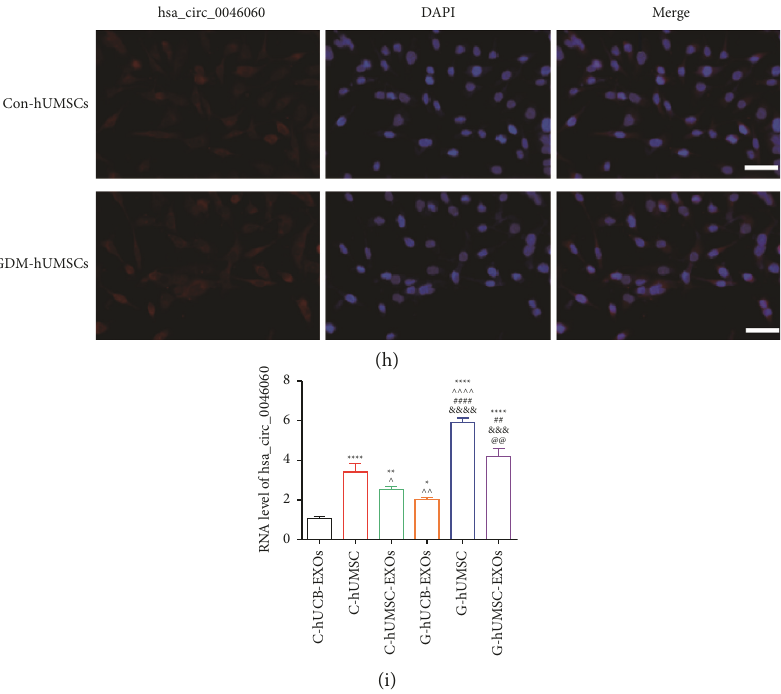
Figure 1: The identification of hUMSCs and hUMSC-EXOs and characterization of hsa_circ_0046060. (a) Flow cytometry analysis showing high expression levels of CD90 and CD105 and negative expression of CD45 and CD34 in hUMSCs. (b) Representative TEM micrographs of hUMSC-Exos characterization. Scale bar: 100nm. (c) NTA indicating the particle size and concentration of exosomes. (d) Western blot analysis indicating expression of specific markers of huMSC-EXOs. (e) Agarose gel electrophoresis photograph of RT-qPCR assay showing amplification of hsa_circ_0046060. (f) Sanger sequencing analysis using specific primers for hsa_circ_0046060 indicating the splicing site. (g) FISH assay showing localization of hsa_circ_0046060 in the cytoplasm of hUMSCs. (h) RT-qPCR analysis of has_ circ_0046060 and its host gene mRNA treated with or without RNase R Scale bar: 50 μ m. (i) has_circ_0046060 expression levels in C-hUCB-EXOs, C-hUMSC, C- hUMSC-EXOs, G-hUCB-EXOs, G-hUMSC and G-hUMSC-EXOs as determined by qRT-PCR